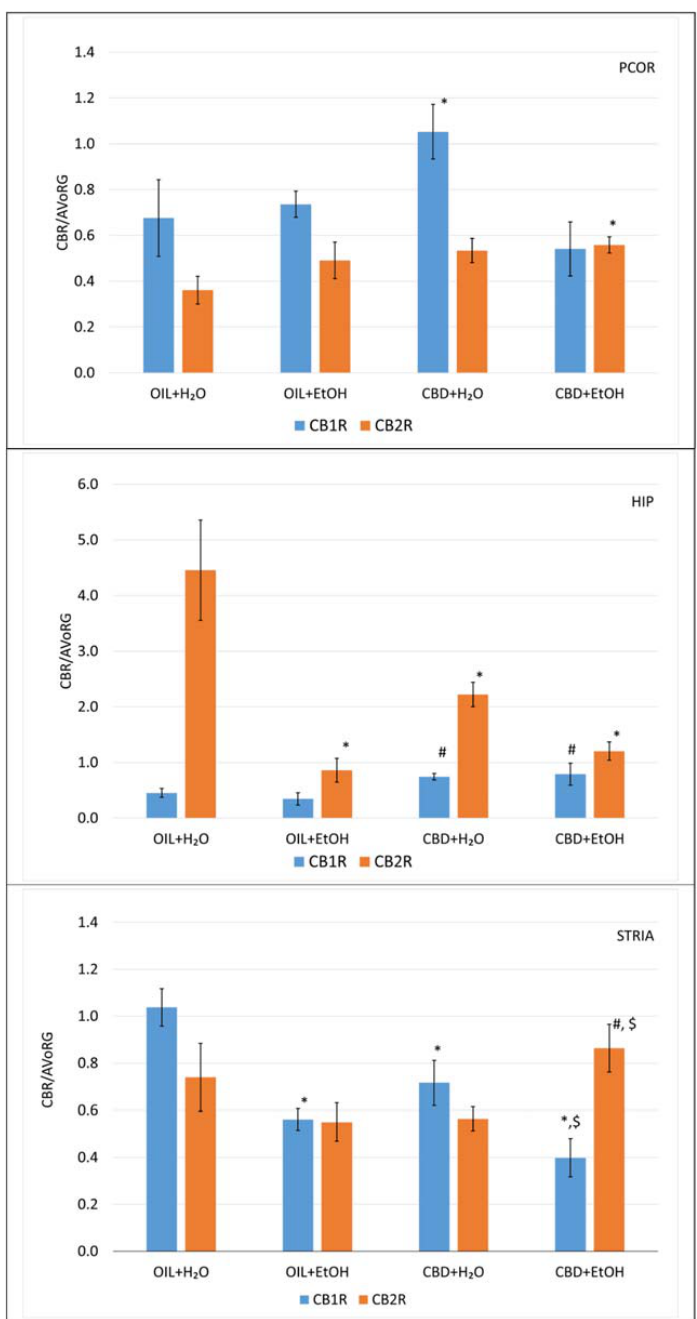
Figure 6. The effect of repeated once ‐ a ‐ day administration of CBD (cannabidiol; 20 mg/kg, p.o.) or